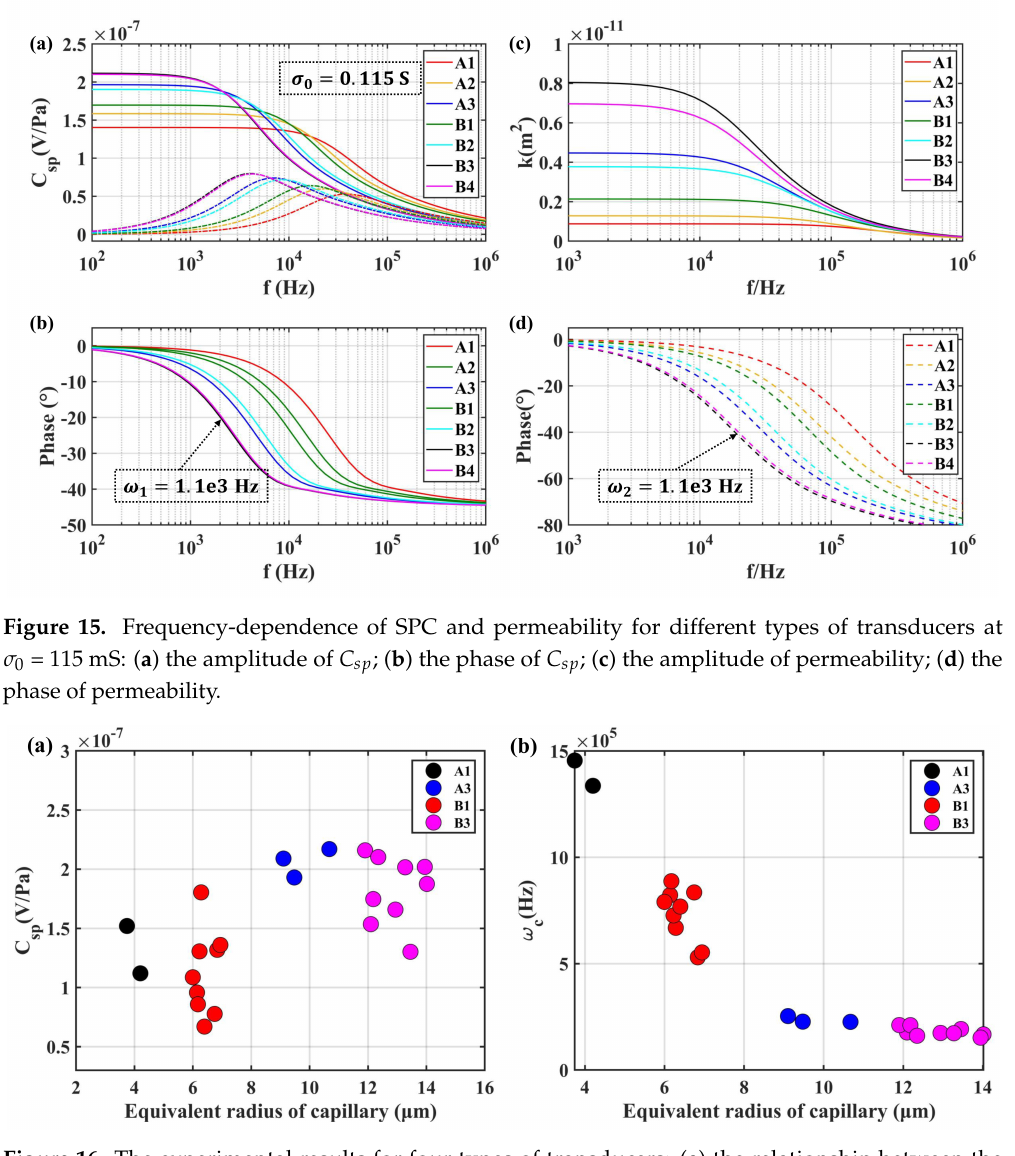
Figure 16. The experimental results for four types of transducers: ( a ) the relationship between the equivalent capillary radius and steady-state SPC; ( b ) the relationship between the equivalent capillary radius and transition